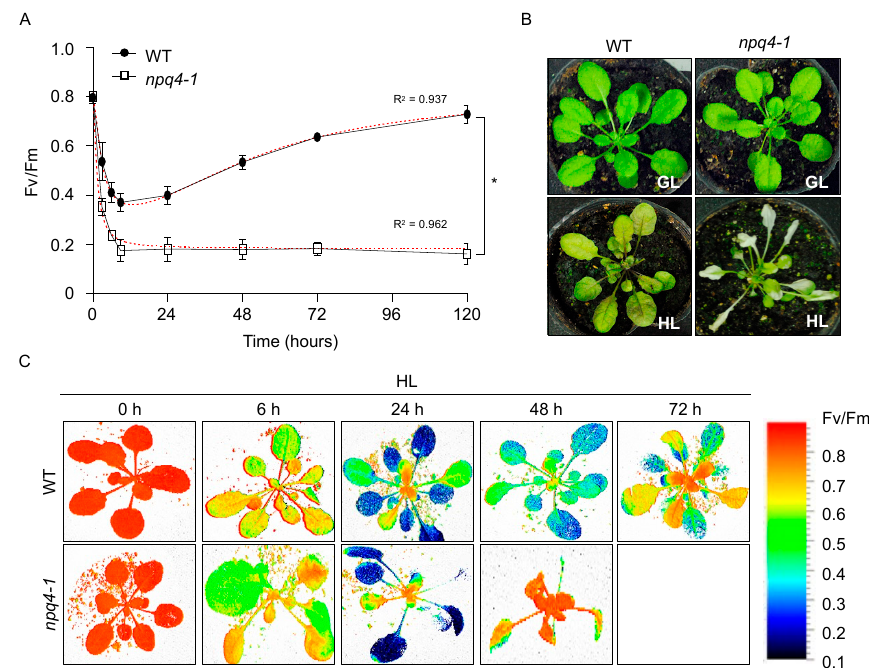
Figure 1. Changes in Fv/Fm and visible phenotypes of WT and npq4-1 mutants during high light illumination. ( A ) Changes in the photochemical efficiency of PSII (Fv/Fm) during high light (HL) treatment for up to 5 days. The means and standard errors (±SE) from three to five replicates are shown. Regression line plotted as red dashed line estimated via nonlinear least square regression. R 2 denotes the regression coefficient. Significance differences of fitted curves are indicated by asterisks (* p < 0.05) compared to the WT as determined by unpaired Student’s t test; ( B ) The visible phenotype of the WT and npq4-1 mutants grown under growth light (GL) at 70 μ mol photons m − 2 s − 1 for 4 weeks after transfer to HL at 700 μ mol photons m − 2 s − 1 for 3 d; ( C ) Chlorophyll fluorescence images for Fv/Fm. The bar on the right side is the color scale for Fv/Fm.